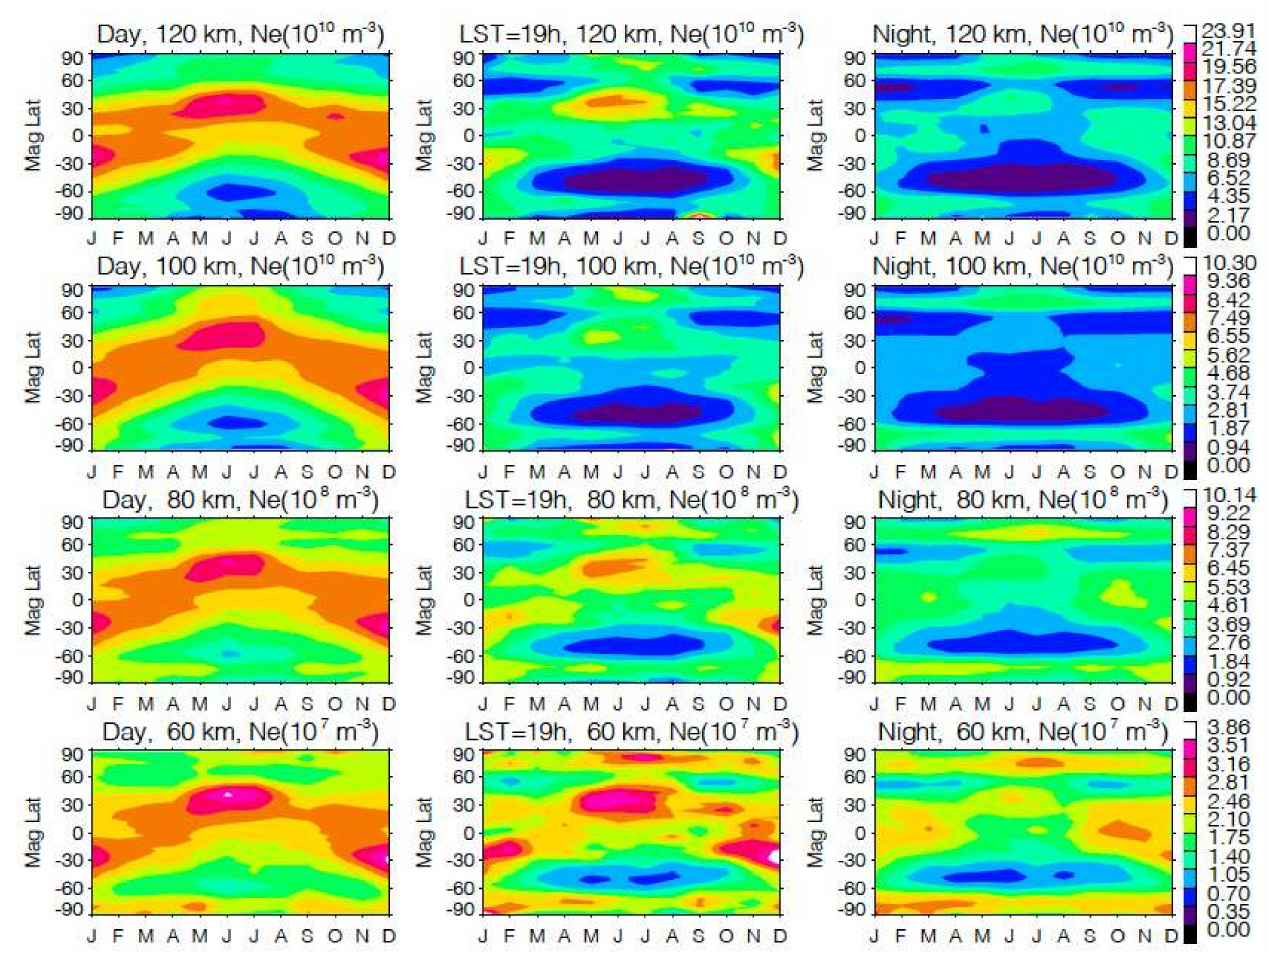
Figure 11. Seasonal variations of daytime ( left ), post-sunset ( middle ), and nighttime ( right ) N e (in 10 10 m − 3 ) at 70, 90, and 110